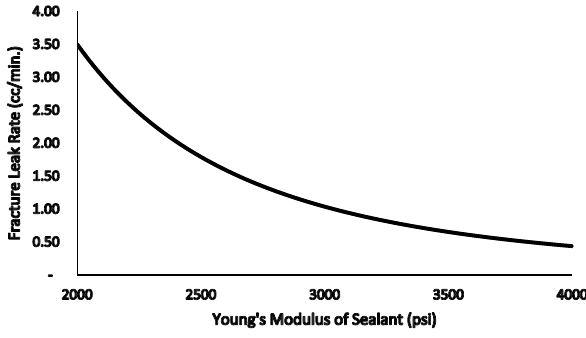
Fig. 9 Model-calculated fracture leak rate sensitized to Young’s mod- ulus of